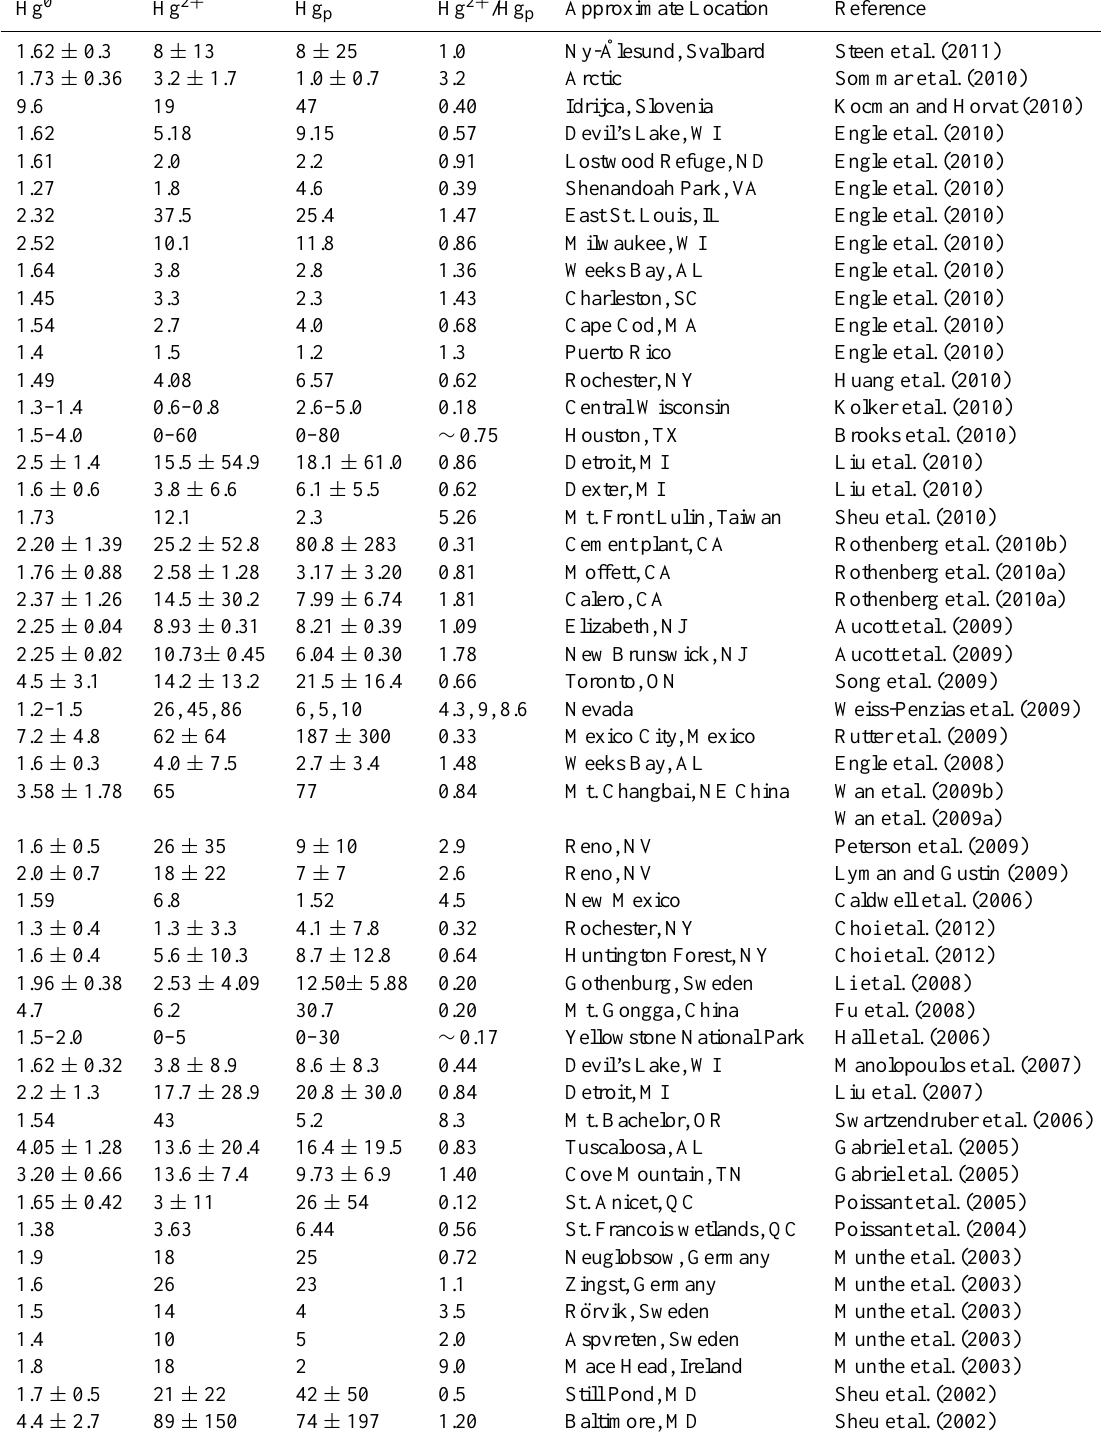
Table 1. Summary of literature data of Hg 0 , Hg 2 + and Hg p measurements published from 2002 to 2010. All concentrations in pgm − 3 . Uncertainties, where available, and significant figures are as reported by authors. Hg 2 + /Hg p ratios were calculated from reported speciation data. “ ∼ ” indicates Hg 2 + /Hg p estimations based on concentration ranges reported by original